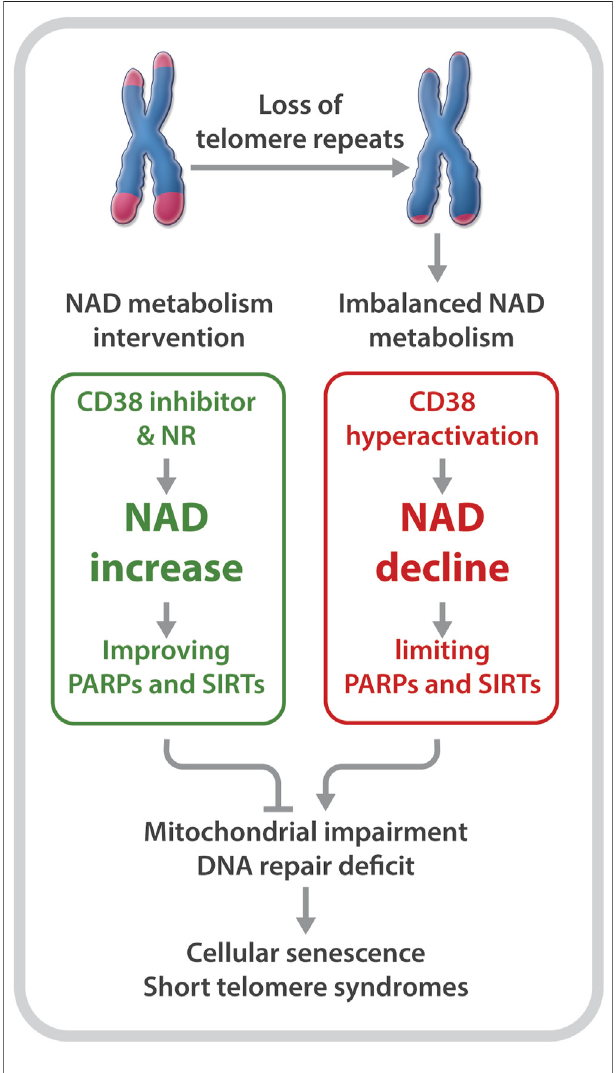
FIGURE 2 | Short telomeres evoke an imbalance in NAD metabolism in primary cells derived from patients with DC. NR supplementation and CD38 inhibitionimproveNADhomeostasisandthebiologicalpathwaysregulatedby PARPs and SIRTs, which diminish telomere DNA damage and mitochondrial impairment, and delay replicative